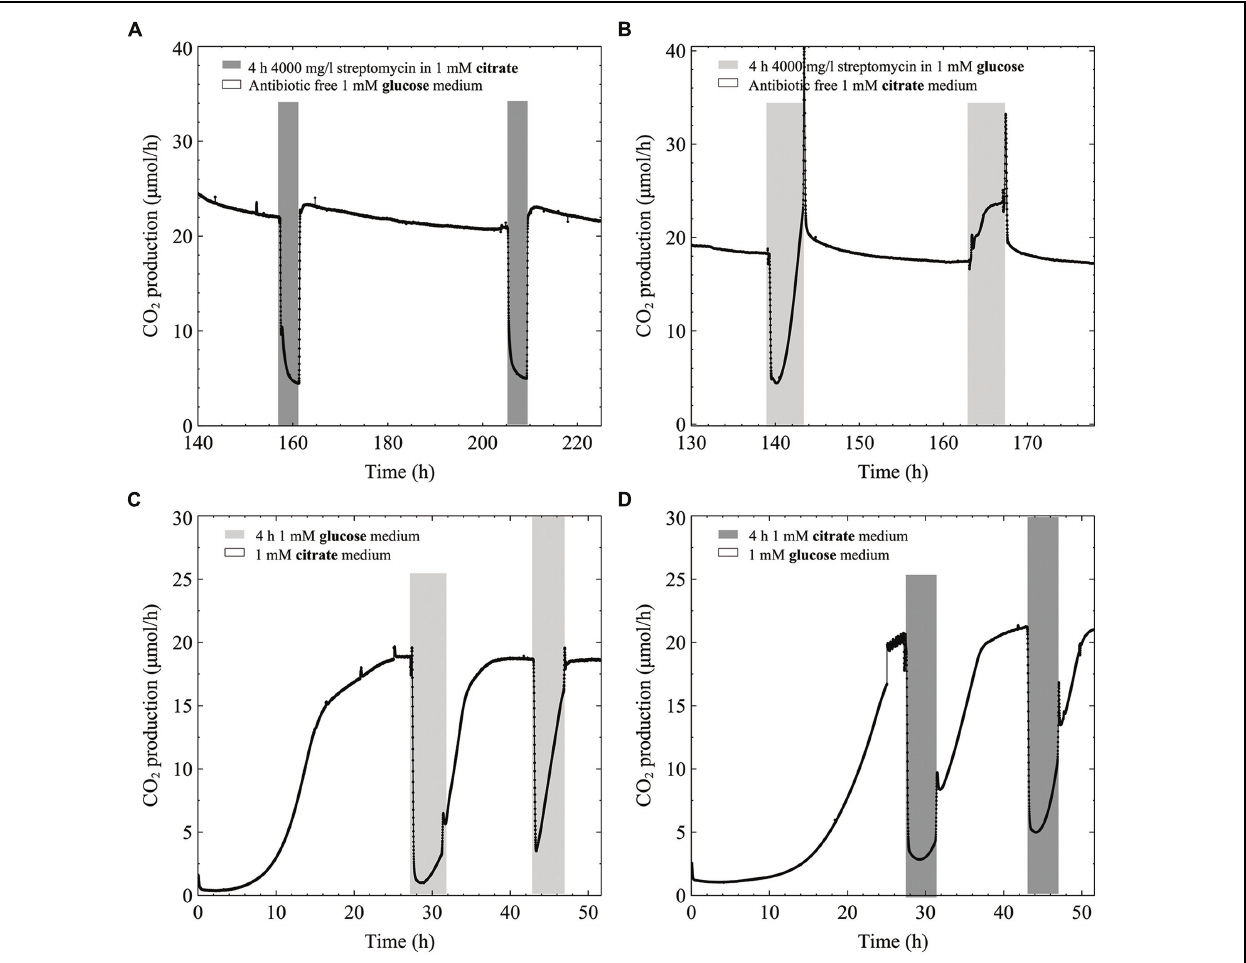
FIGURE 4 | CO 2 production ( µ mol/h) of multispecies biofilms grown in defined medium: (A) 1 mM glucose as the carbon source exposed two times to 4000 mg/l streptomycin in 1 mM citrate, (B) 1 mM citrate exposed two times to 4000 mg/l streptomycin in 1 mM glucose, (C) 1 mM citrate